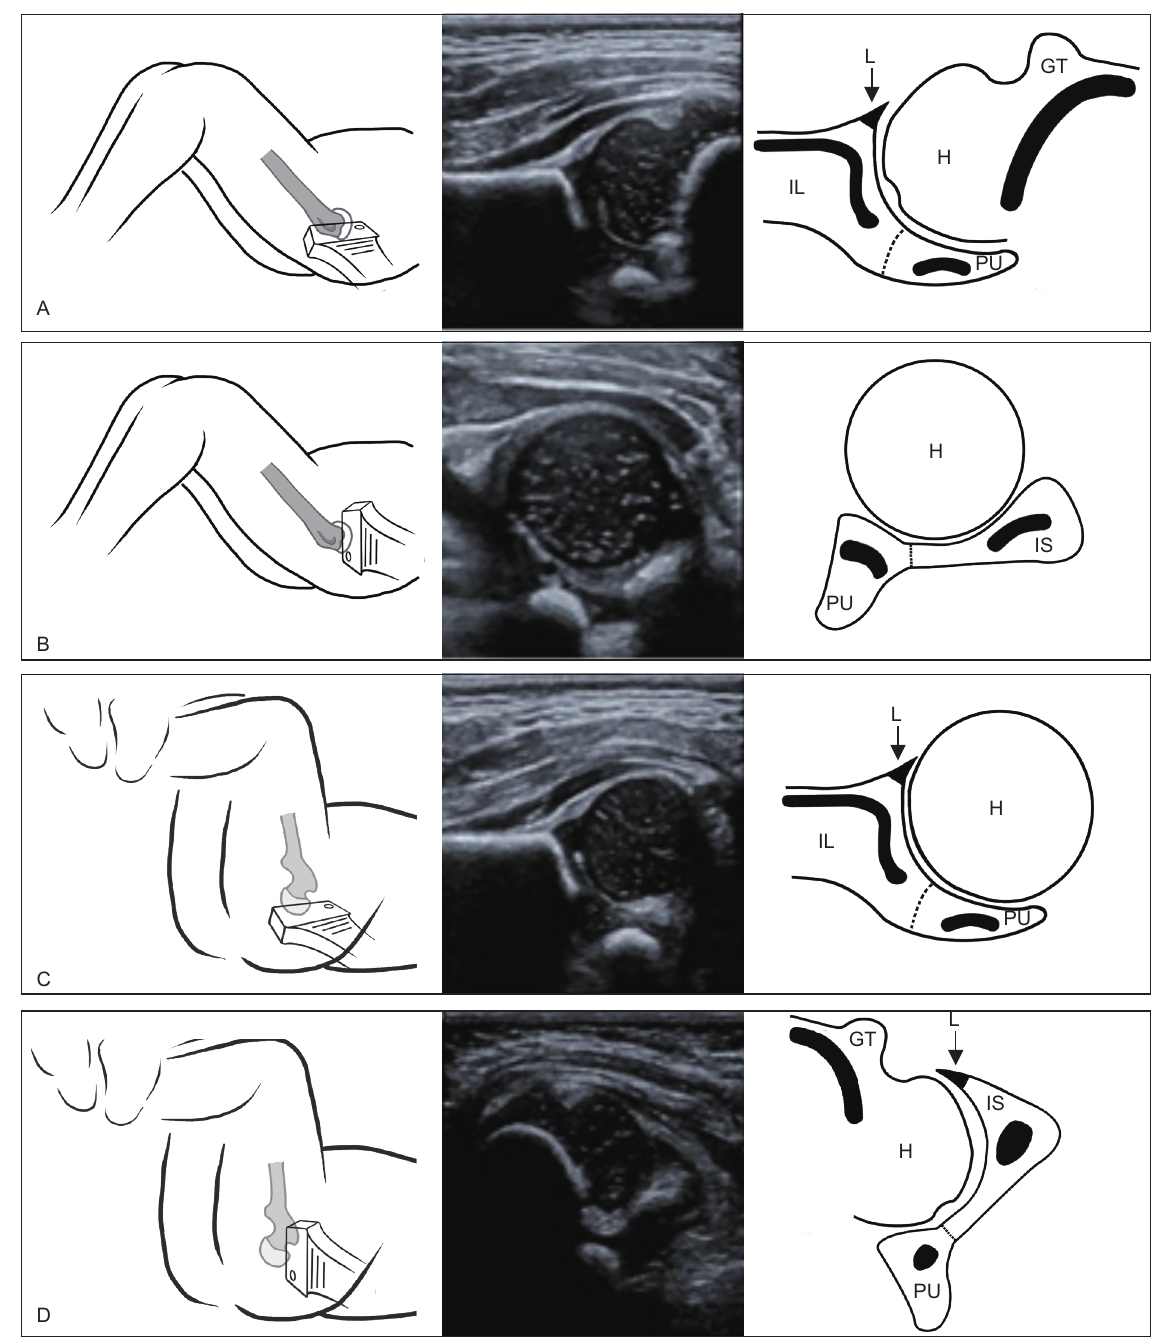
Figure 2 Hip ultrasound of the body position, standard image and anatomic illustration. (A) Neutral posture hip coronal image; (B) Neutral posture hip transverse image; (C) Flexion posture coronal image; (D) Flexion posture hip transverse image. IL, ilium; PU, pubis; IS, ischium; H, femoral head; GT, greater trochanter; L, labrum.